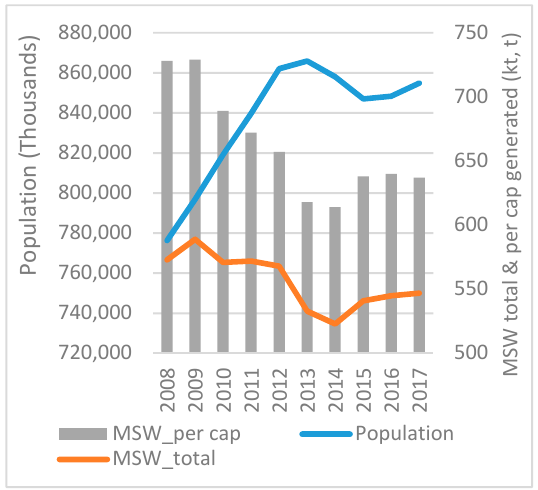
Figure 25. Population and MSW production in Cyprus 2008–2017 (EUROSTAT 2019a, 2019c). Soc. Sci. 2019 , 8 , x FOR PEER REVIEW